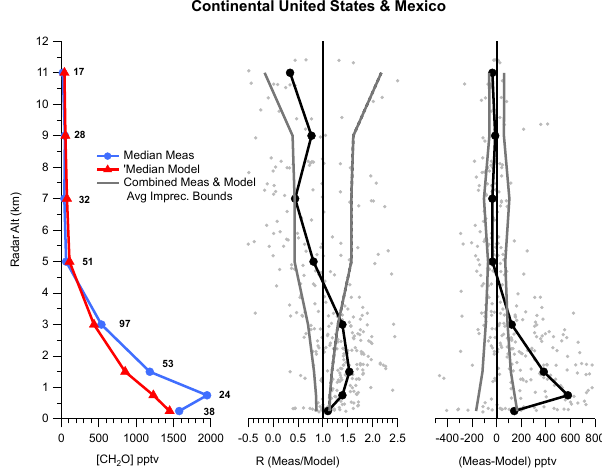
Fig. 5. Time coincident radar altitude bin TDLAS measurement (Meas)-box model (Model) comparisons on the hydrocarbon time base over the continental United States and Mexico (exclusive of Mexico City and Monterrey) during both phases of INTEX-B. The center plot shows the median point-to-point measurement/model ra- tios for each altitude bin (dark circles) while the right side plots the median point-to-point measurement-model differences (dark cir- cles). Individual ratios and differences are shown by the light gray points. The solid gray lines refer to the combined average bin ra- tio and bin difference measurement and model uncertainties at the 2 σ level using measurement imprecision and model constraint un- certainty estimates described in the text. The numbers next to each point on the left plot are the number of points in each